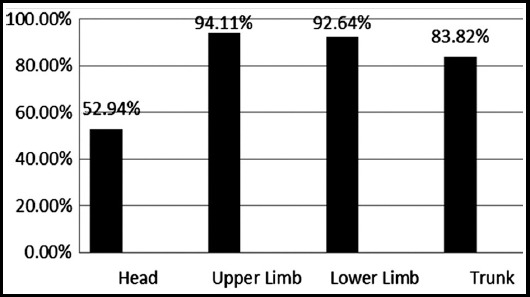
Location of Lesion.